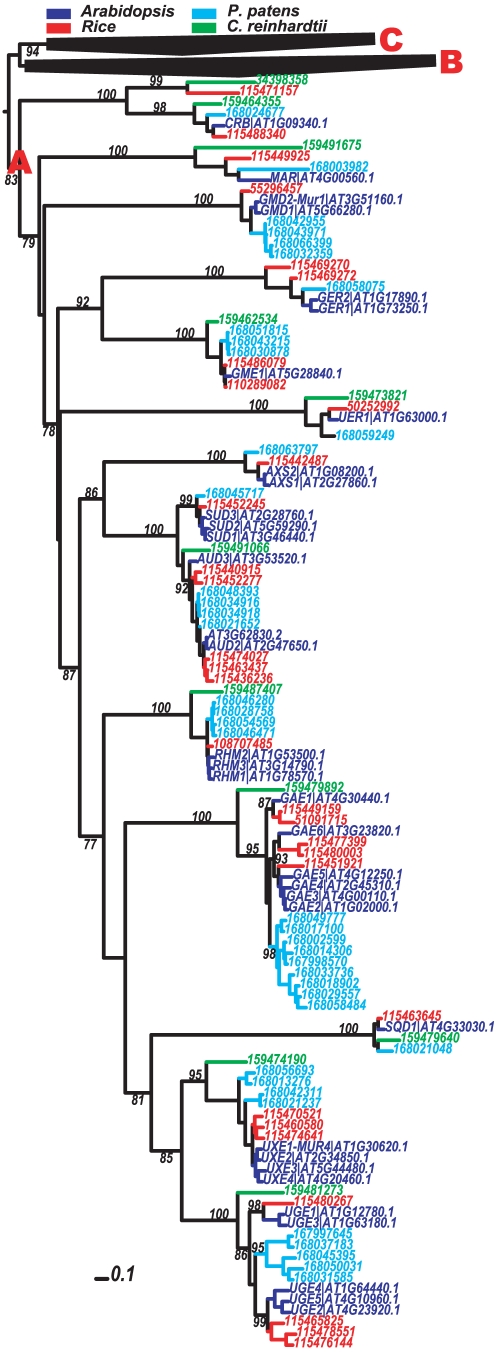
Phylogeny of 257 plant Epimerase domains.The phylogeny is built using PhyML v3.0 and displayed using the Interactive Tree of Life (iTOL) web server (Letunic and Bork, 2007). Bootstrap values beside the nodes indicate the confidence levels with regard to the clustering of relevant proteins into one group. Selected supporting values >70% are shown. SQD1 is UDP-sulfoquinovose synthase. MAR is short for methionine adenosyltransferase regulatory protein, whose exact enzymatic function is not determined yet. CRB is short for chloroplast RNA binding. For other names, see Figure 1 for abbreviations. Note that UXS includes SUD and AUD, UGlcAE is also known as GAE, UAXS is also known as AXS and NRS/ER is also known as UER. Only sub-clades of major clade A are shown and sequence names are indicated using GenBank gi numbers or UniGene IDs. The other two clades are collapsed as black triangles. The scale bar corresponds to 0.1 changes per amino acid position. The complete version of this phylogeny is given in Figure S1.